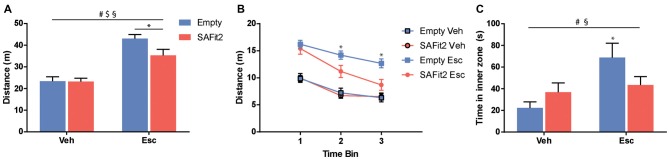
Behavioral alterations in the open field (OF) test. (A) Escitalopram (Esc) administration induced an increase in distance traveled during the test, which was significantly ameliorated by SAFit2 treatment. (B) When splitting the test in three time-bins of 5 min each, we found no differences between the Esc groups in the first 5 min. However, in time bins 2 and 3, co-medication significantly decreased the distance traveled when compared to the Empty/Esc group. (C) The exploration of the inner zone of the OF is considered a measure of anxiety. Esc significantly increased the inner zone time of the animals, and this effect was blocked in SAFit2 treated mice. #Main Esc effect, $main SAFit2 effect, §Esc–SAFit2 interaction effect, *significant post hoc effect at p < 0.05.